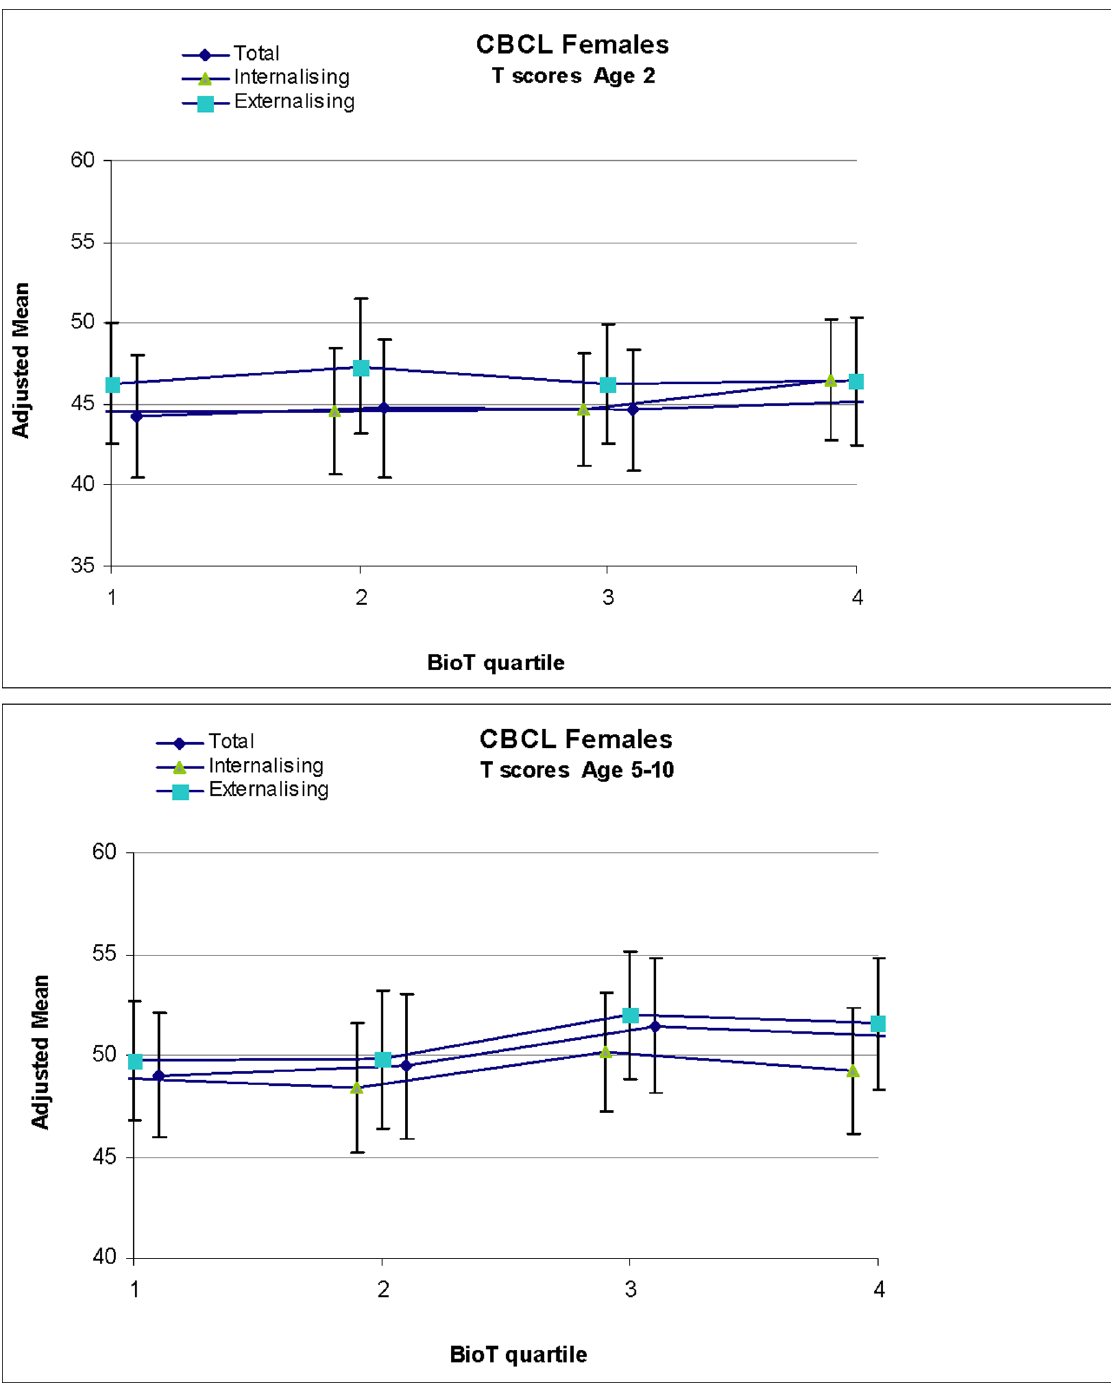
Figure 1. Mean CBCL total, internalizing and externalizing T-scores at age 2 and age 5–10 by BioT quartile for females. doi:10.1371/journal.pone.0059991.g001 rates antisocial or under-controlled behavior, and an Internalizing Scale which rates inhibited or over-controlled behavior. In addition, there are eight subscales, which assess problems in more specific areas. These are labelled: withdrawn behavior, somatic complaints, anxiety/depression, delinquency, aggression, social, thought and attention problems [15]. On all scales, raw scores and T-scores (standardised by age and sex) are available. [15]. Higher